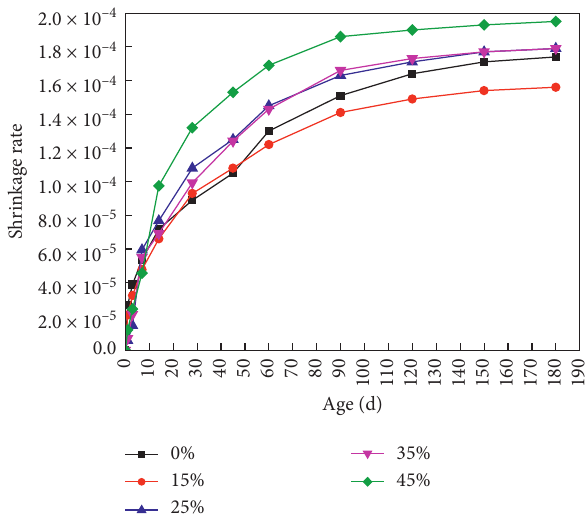
Figure 5: Effects of varying fly ash substitution levels, water-binder ratios, and ambient humidities (reflected as S1–S9 concrete mix- tures) on the CFA’s shrinkage rate.